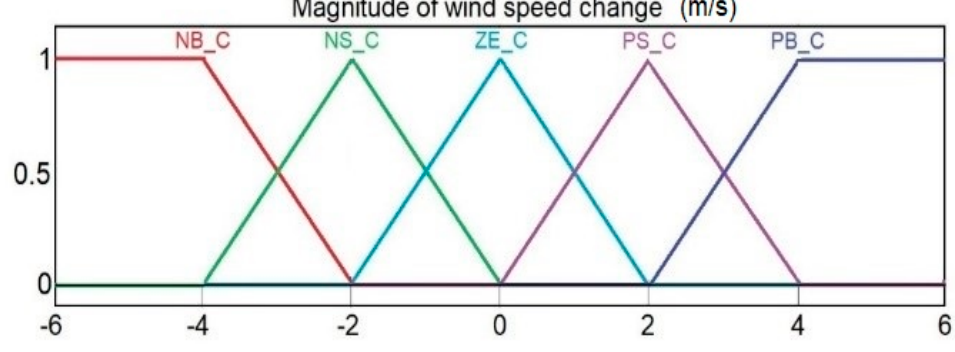
Figure 12. Membership functions for changes in wind speed value.